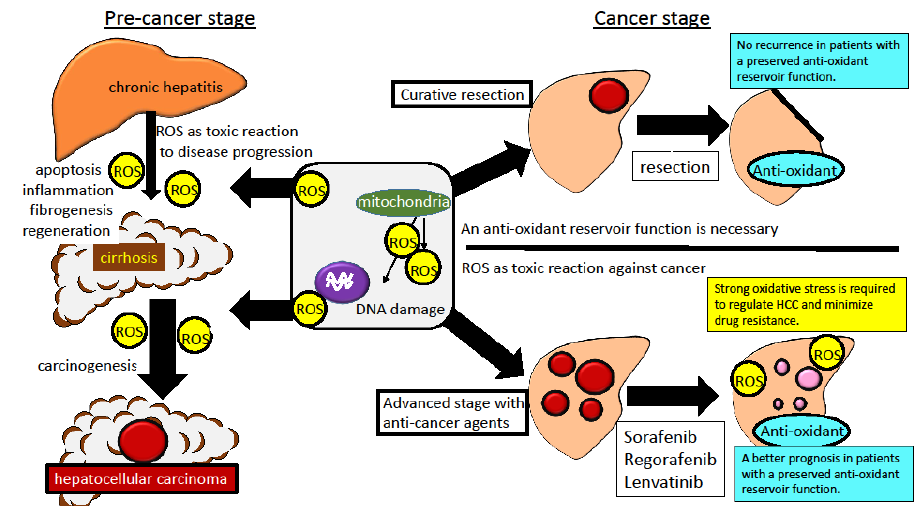
Figure 2. A conceptual diagram of oxidative stress in the pre- and post-carcinogenesis stage.